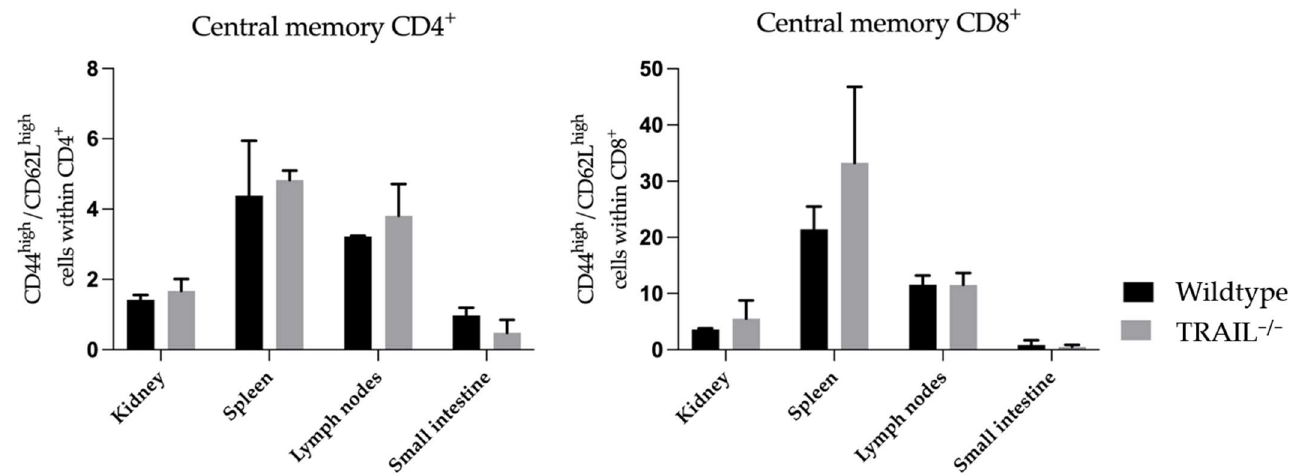
Figure 6. Histogram compares means ± SEM of CD4 + and CD8 + central memory T-lymphocytes in the kidney, spleen, lymph nodes, and small intestines of TRAIL −/− mice versus wildtype C57BL/6 mice ( t -test, n = 6 per group).